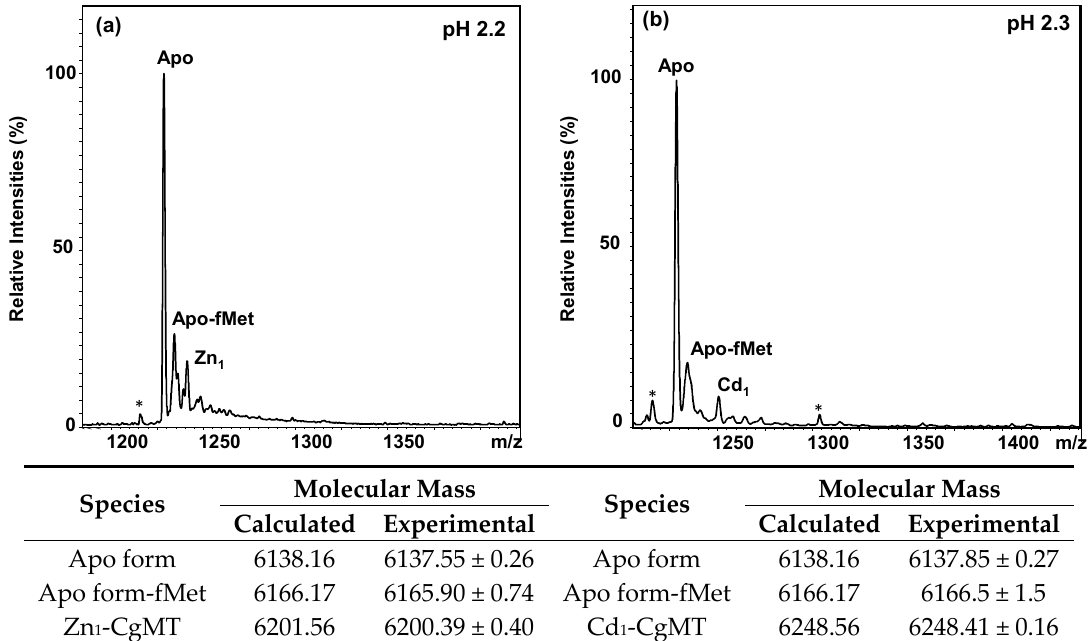
Figure 3. The most abundant +5 charge state from representative ESI-MS spectra of CgMT synthesised in the presence of: ( a ) Zn(II); or ( b ) Cd(II), recorded at acidic pH (10 mM NH 4 HCO 3 , 10% MeOH, 2% formic acid). Peaks marked with an asterisk (*) indicate impurities.